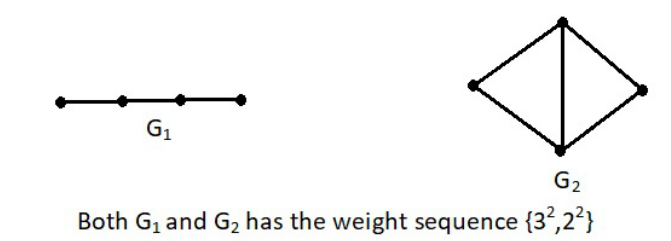
Figure 1. Path and a Cyclic graph having the same weight